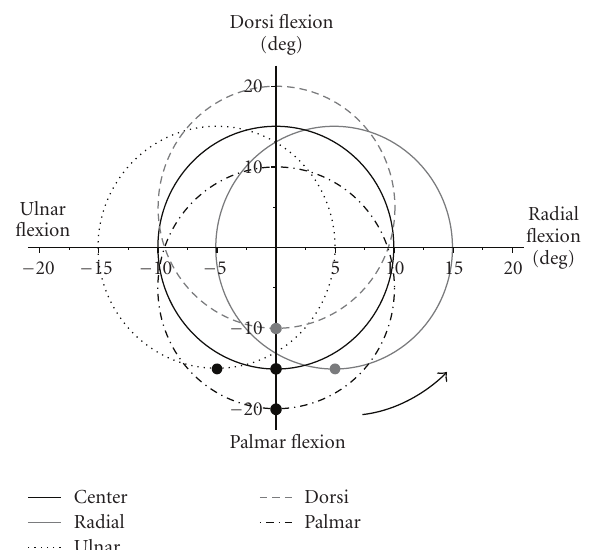
Figure 4: Target joint angle trajectories for IDM learning. Each movement had di ff erent